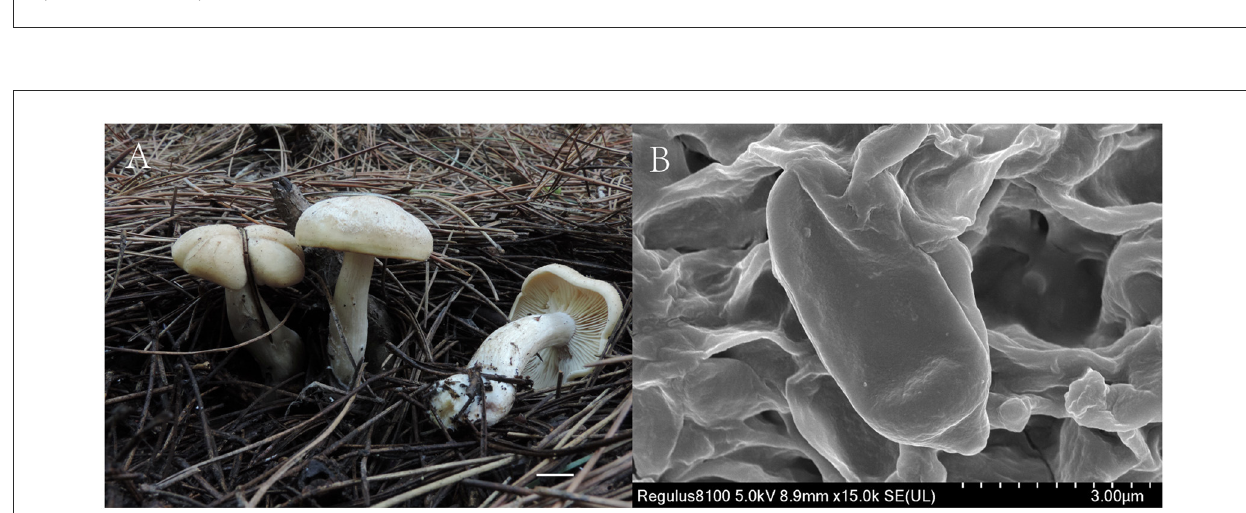
FIGURE3 ML and BI analysis of Ossicaulis based on ITS and nrLSU sequences. PP ≥ 0.95 (left) and BS ≥ 60 (right) are indicated on branches. Hypsizygus ulmarius is rooted as the out-group. Newly generated sequences for Ossicaulis borealis are highlighted in boxes. GenBank accession numbers are provided after the species name.